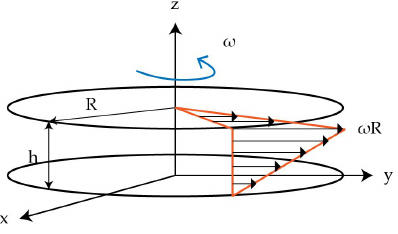
Figure 4. Velocity distribution of a parallel-plate rheometer (according to